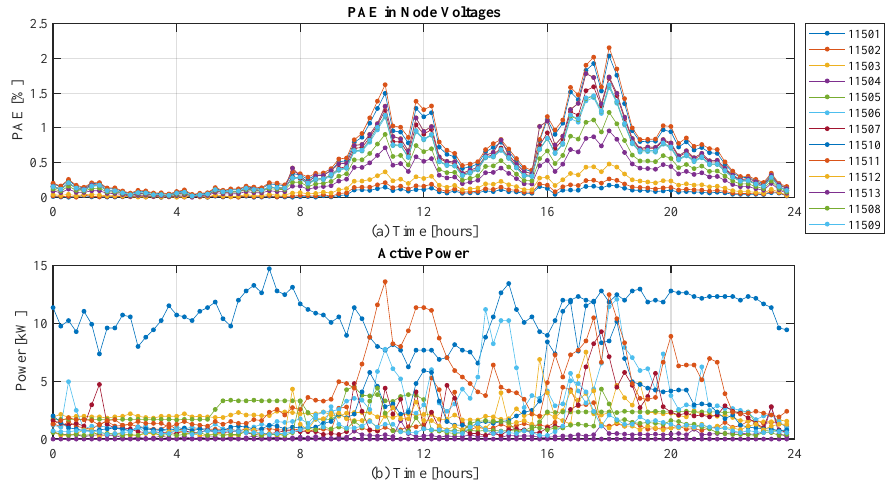
Figure 8. Plot of DSSE simulation with measurement errors (a white Gaussian noise of σ = 0.01) using measurements recorded on 7 January 2018 ( a ) PAE in node voltages and ( b ) node active